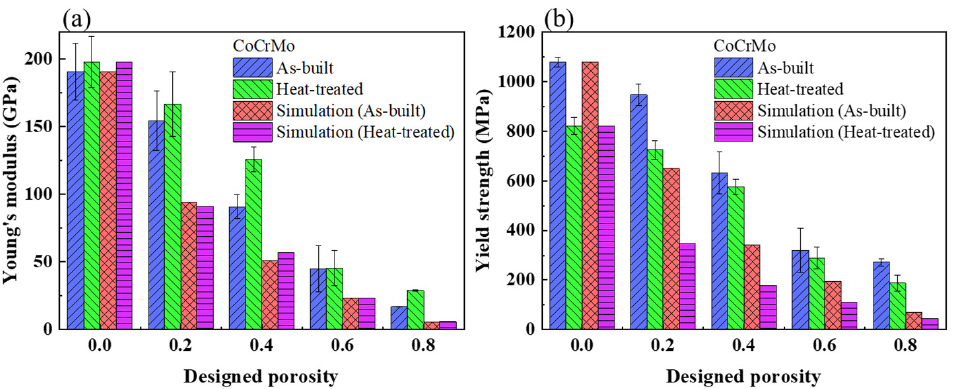
Figure 7. ( a ) Young’s modulus and ( b ) yield strength in the as-built and heat-treated CoCrMo alloys determined from the experiment and simulation with different, designed volume